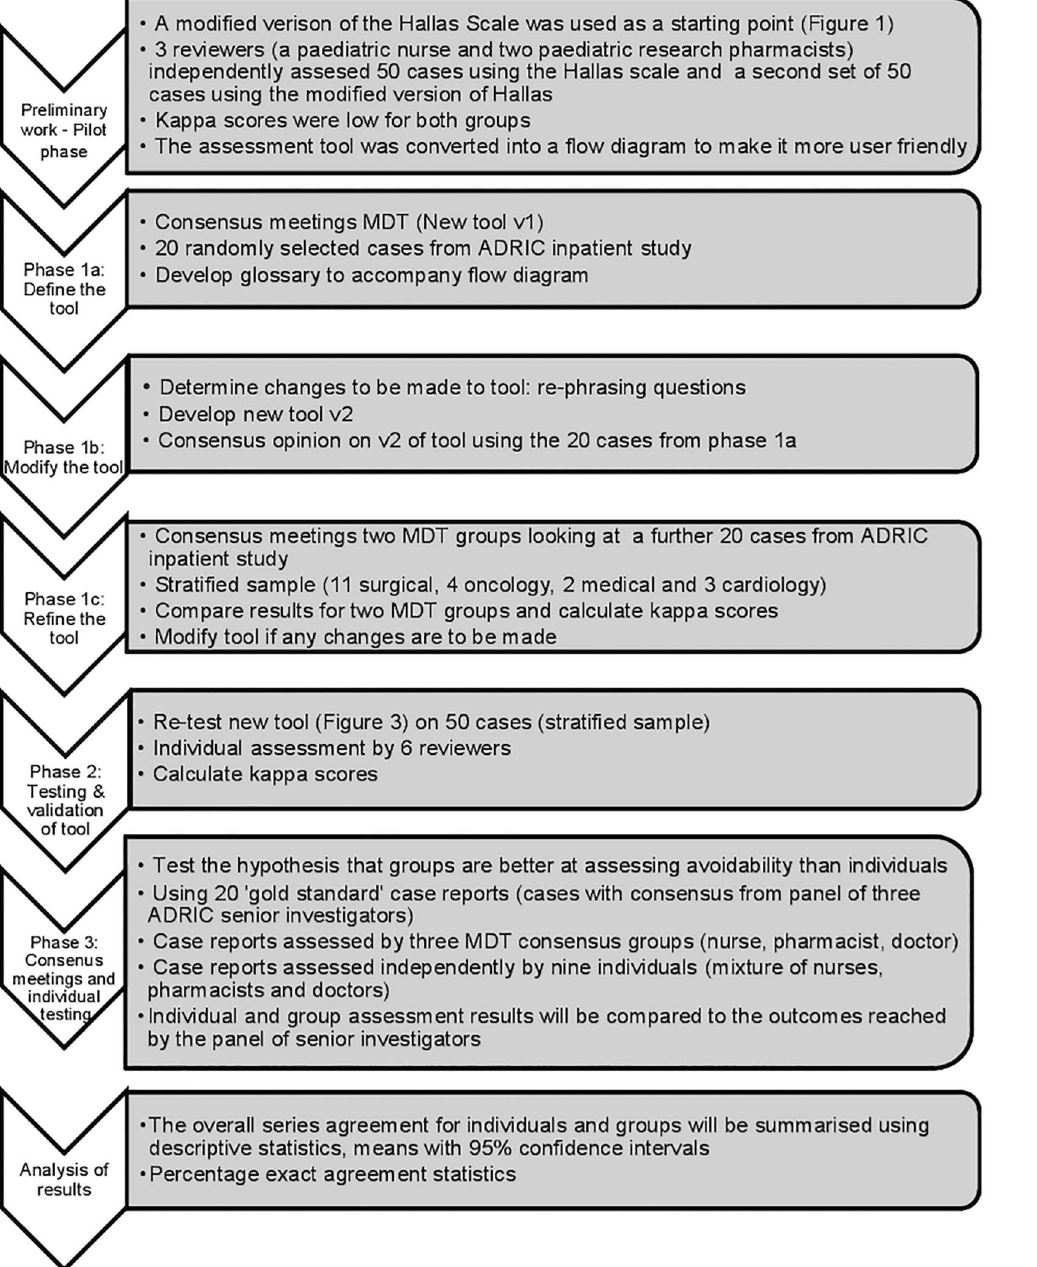
Fig 2. Flow chart of the development of the Liverpool ADR avoidability assesmsent